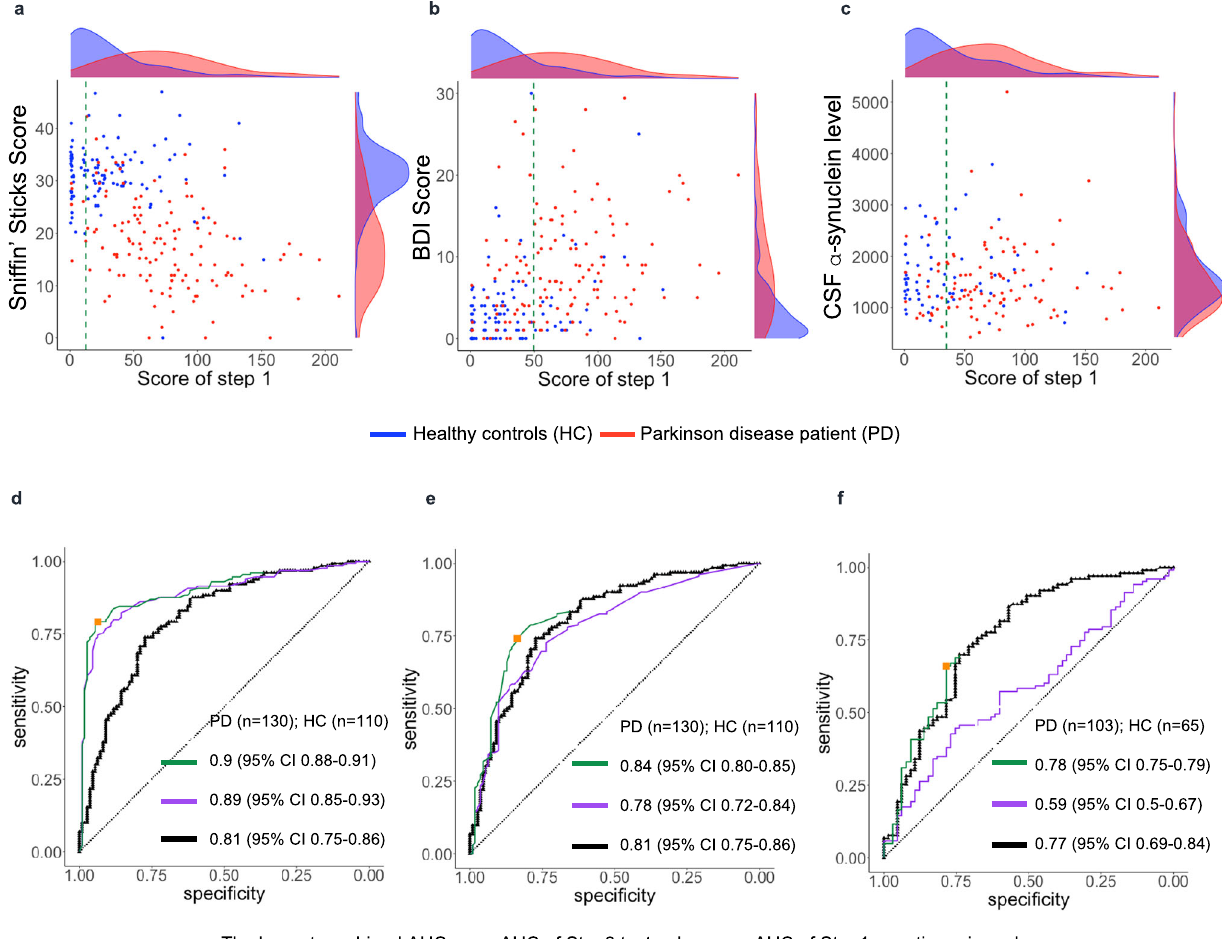
Fig. 6 Illustration of effect sizes for steps 1 and 2 in a screening-adapted version of the PREDIGT Score (Model 2) using three distinct objective test results in Step 2. In a and d olfaction was measured by Snif fi n ’ Sticks test; b and e depression measured by the Beck ’ s Depression Inventory (BDI); c and f total α -synuclein concentration measured in the cerebrospinal fl uid. Panels a – c show the relation between the Step 1 PREDIGT Questionnaire score (x-axis) and Step 2 test score ( y -axis) by scatter plots with corresponding score densities. In a – c , blue represents the healthy control group (HC), red represents the group of Parkinson ’ s disease patients (PD). In d – f , corresponding, extended ROC plots are shown. Vertical, dashed, green lines in panels a – c represent the Step 1 thresholds corresponding to the largest combined AUC of Model 2, also represented in d – f by a green line. Black and purple ROC curves represent the Step 1 questionnaire and the Step 2 clinical test, separately. AUC, value for the area under the receiver operating characteristic (ROC) participants, its AUC value was 0.64 (95% CI 0.56 – 0.71) (Fig. 5c).